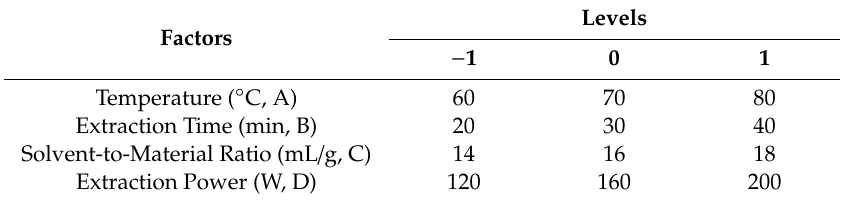
Table 4. Independent variables and their levels used in the Box–Behnken design (BBD).